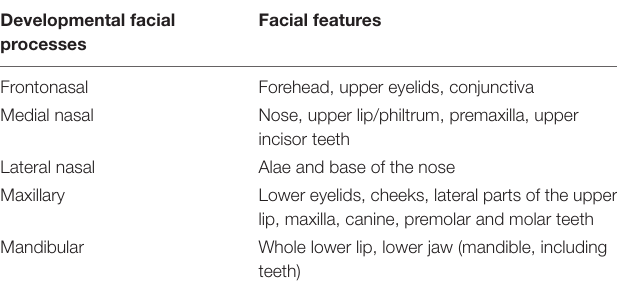
Developmental facial